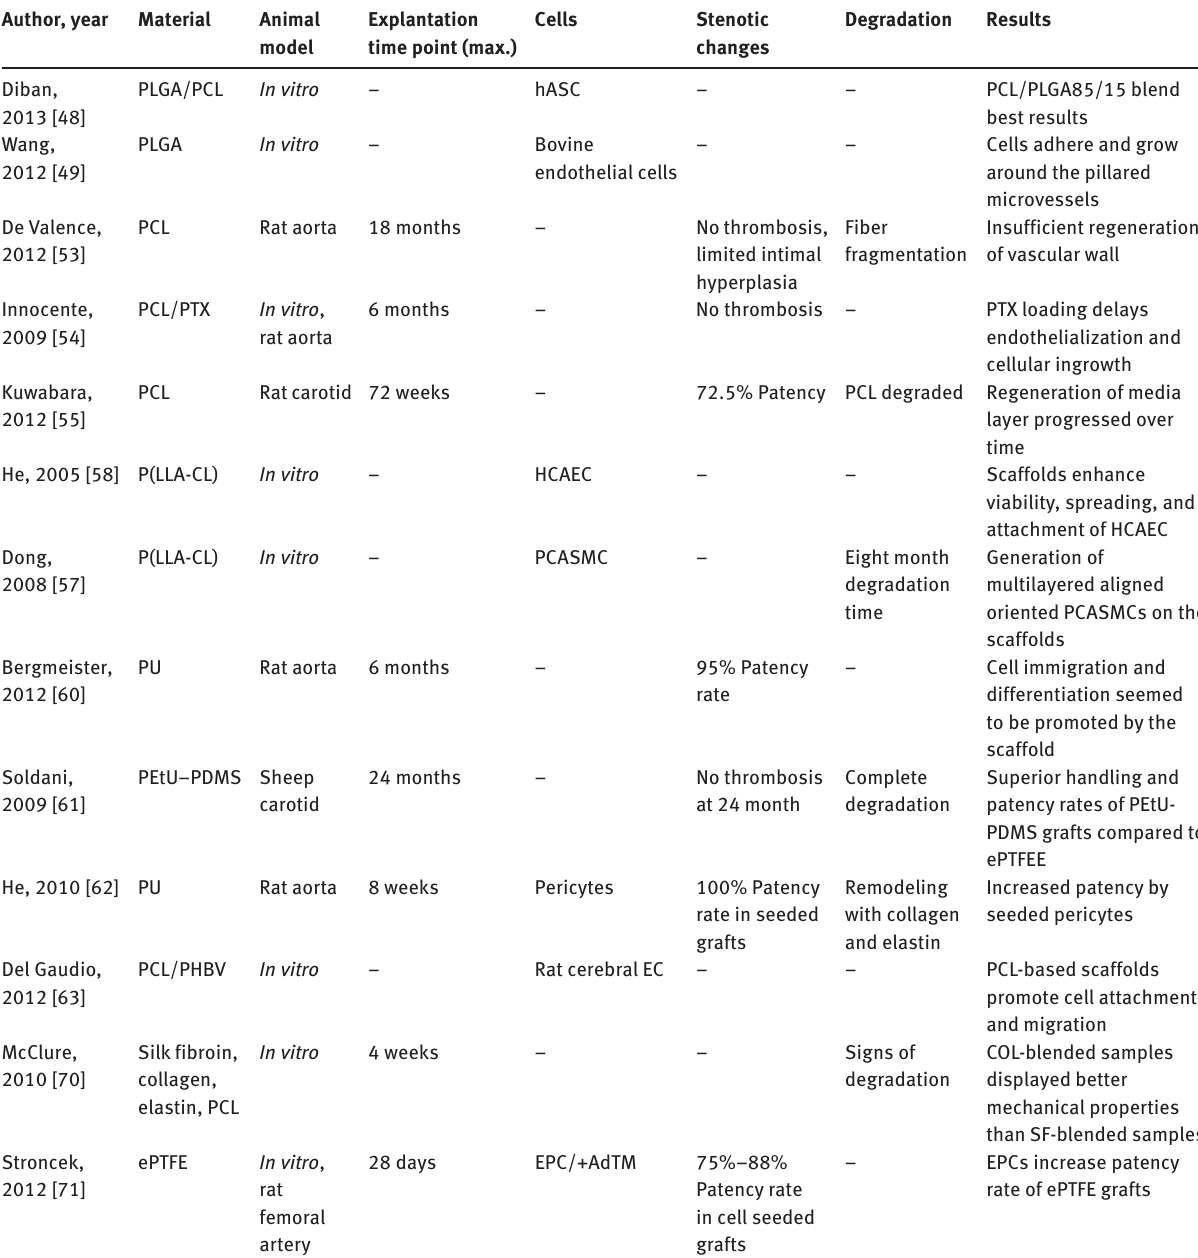
Table 2 Properties of different nanomaterials of vascular